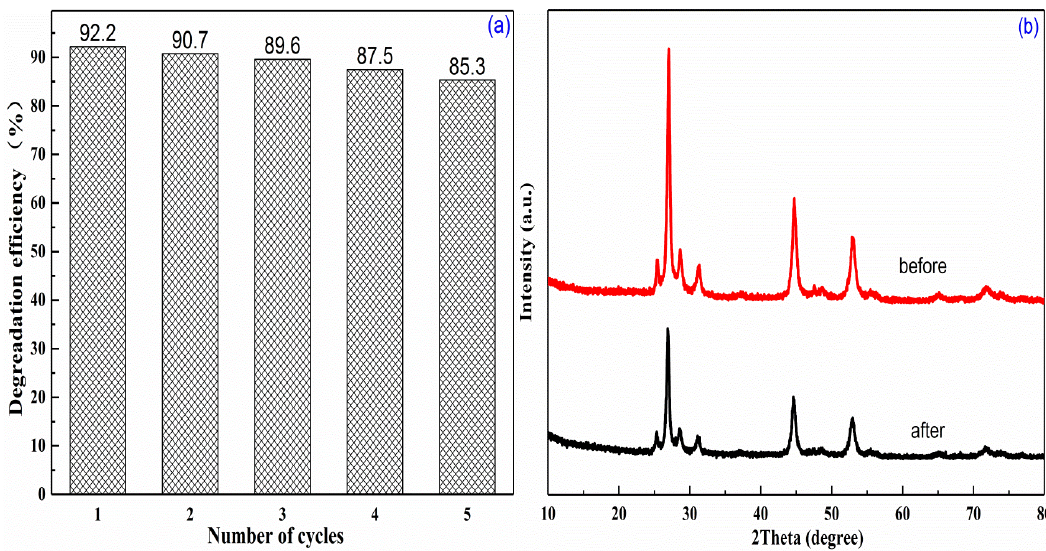
Figure 8. ( a ) Recycling tests for the photocatalytic degradation of MO over 0.3ZCS sample under visible light irradiation; ( b ) Comparison of XRD patterns of 0.3ZCS sample before and after five cycles